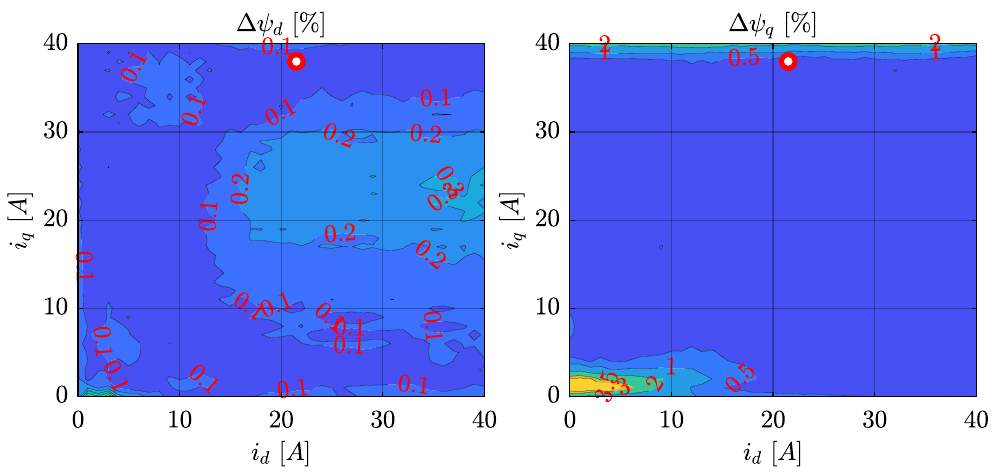
Figure 17. Flux linkage estimation difference between the CSM and proposed method for d -axis ( left ) and q -axis ( right ).